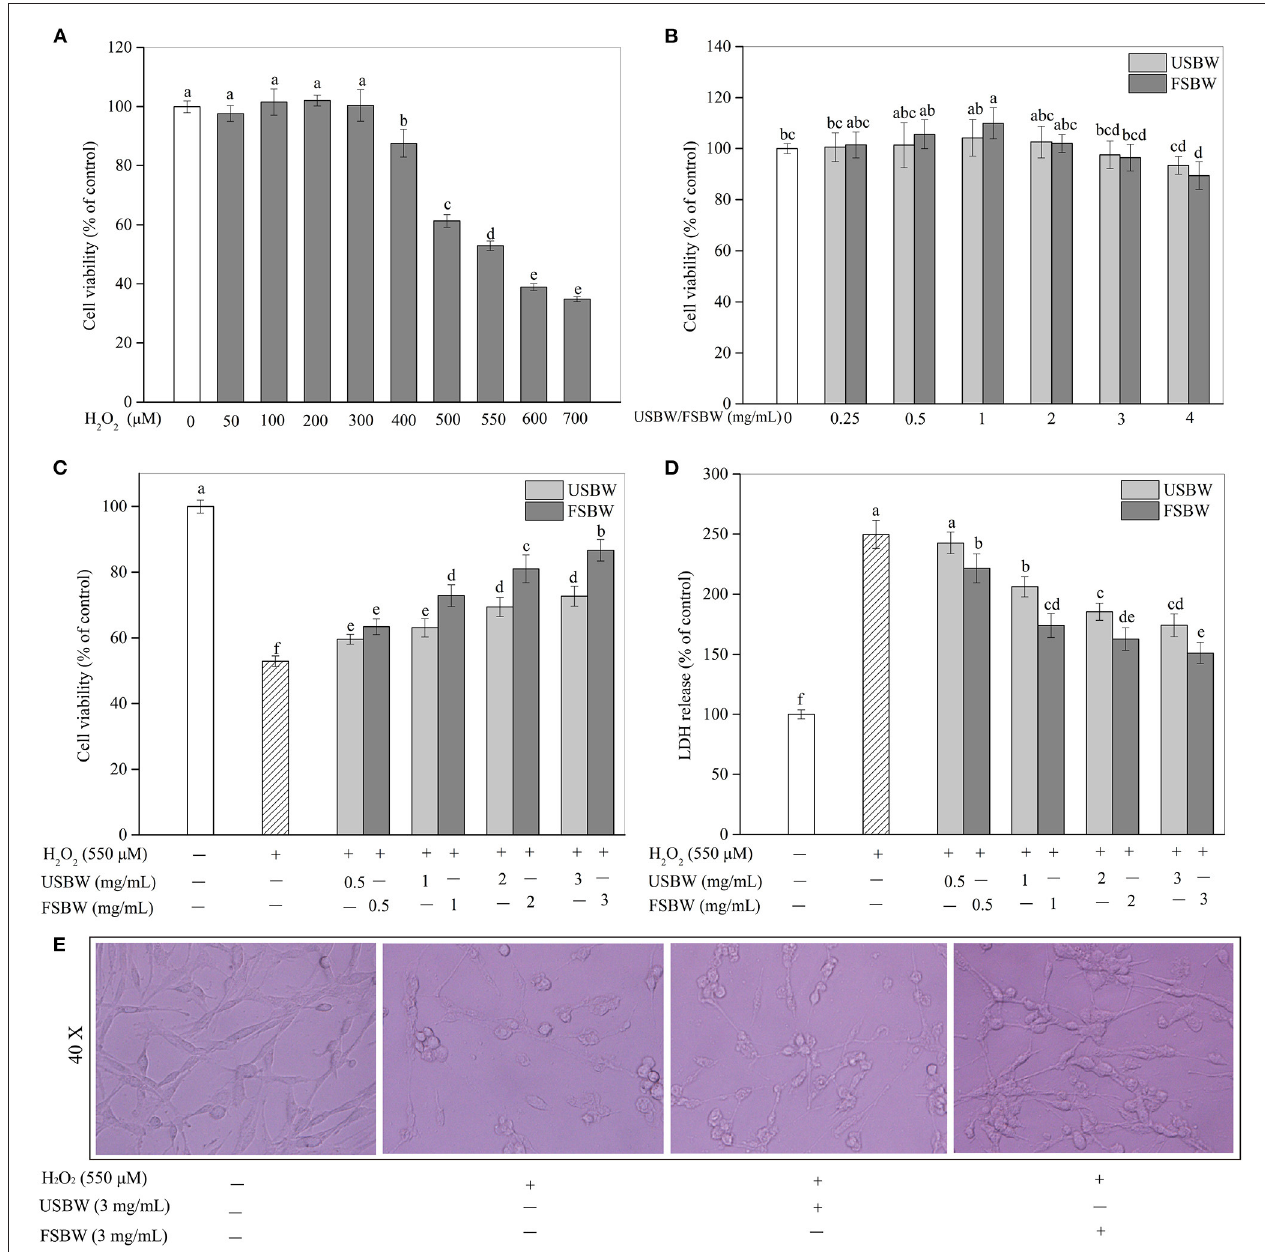
FIGURE 2 | Cytotoxicity and the protection of USBW and FSBW extracts on H 2 O 2 -induced oxidative damage. (A) Cytotoxicity of H 2 O 2 ; (B) Cytotoxicity of USBW and FSBW extracts; (C) Cell viability; (D) LDH levels; (E) PC12 cell morphology. p < 0.05 was considered as the significant level. The small letters were used to indicate the significant difference and the ordering of